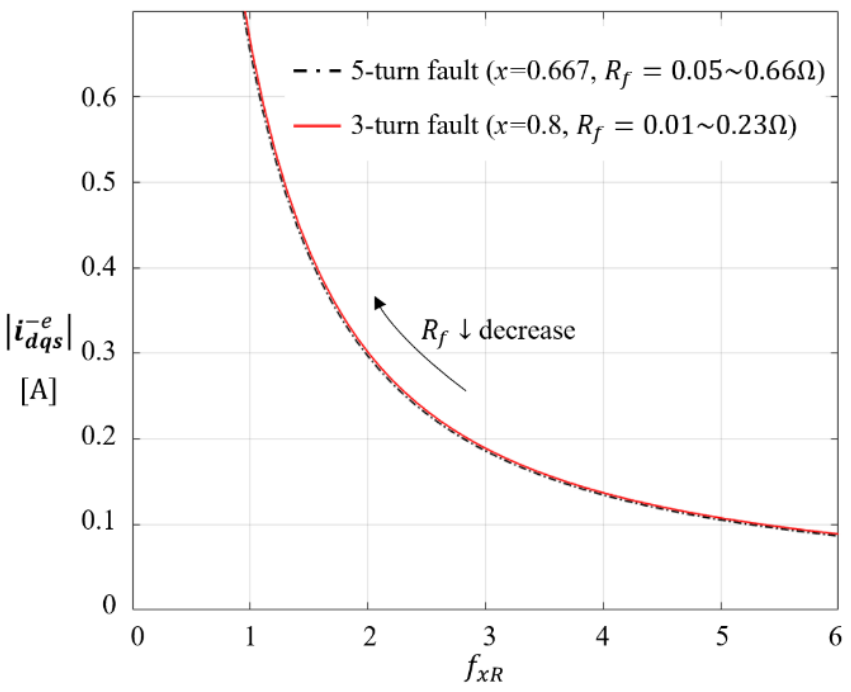
Figure 3. Calculated negative sequence current vs. 𝑓 (cid:3051)(cid:3019) with 3-turns and 5-turns faults.